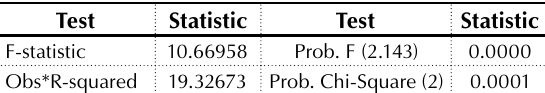
Table 2. Breusch-Godfrey Serial Correlation